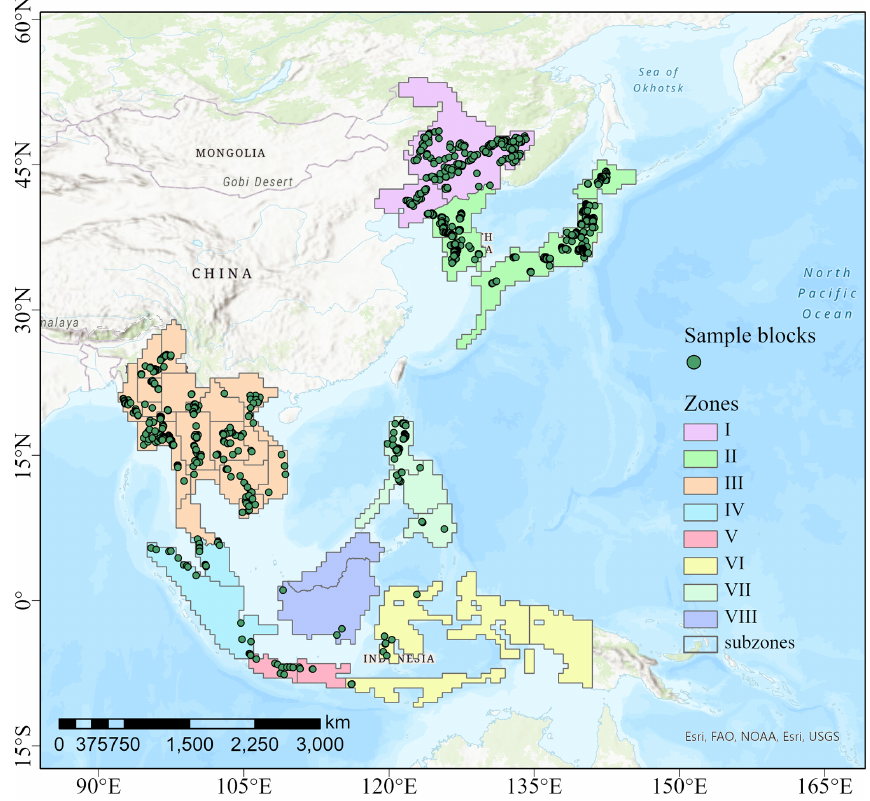
Figure 1. Agroecological zones and 100m radius sample blocks in SE and NE